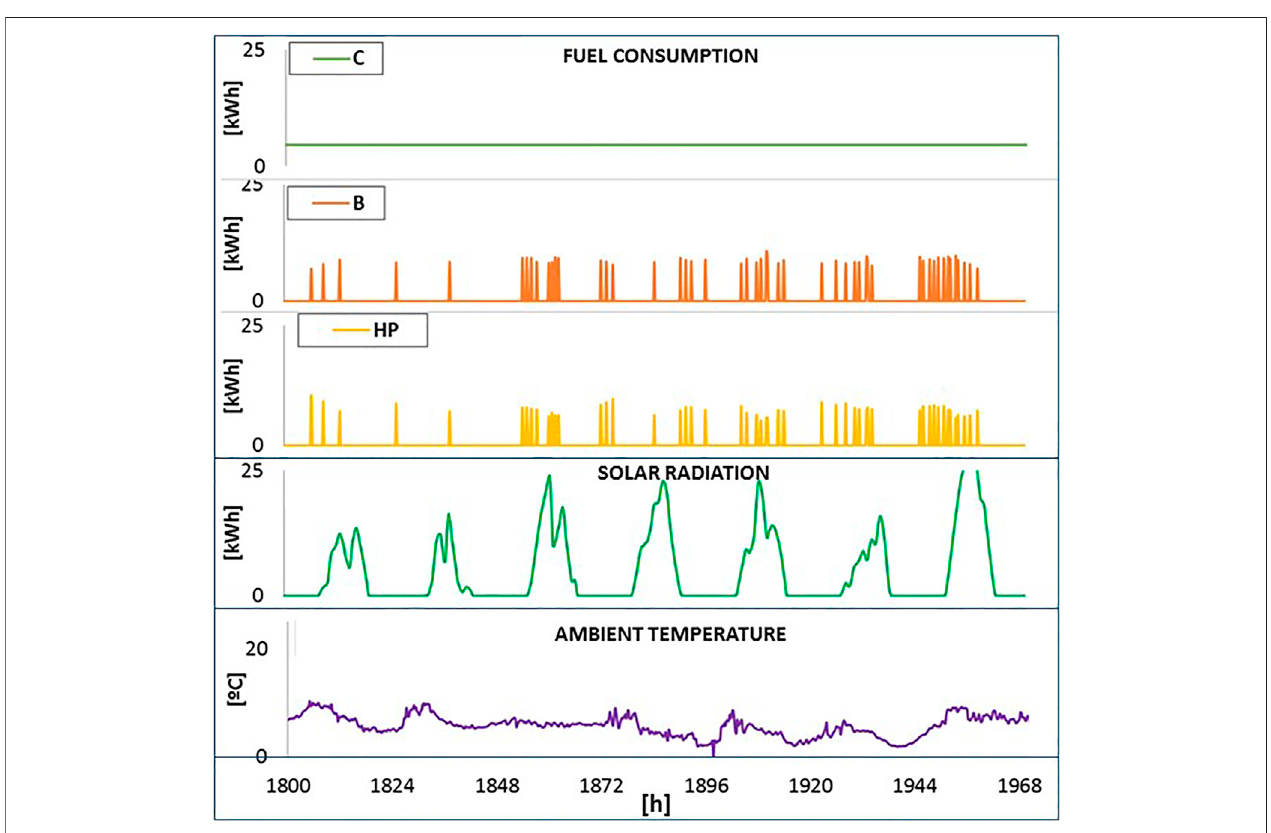
FIGURE 8 | Fuel consumption along a week in March.